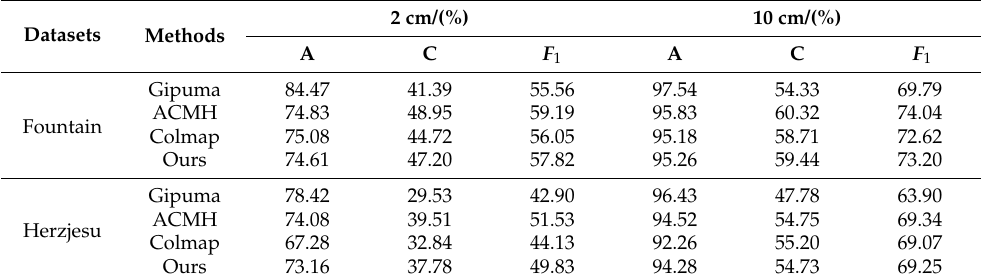
Table 3. The precision comparison of point clouds with different methods in the Strecha dataset. The accuracy (A), completeness (C), and F 1 score (in %) are evaluated with 2 cm and 10 cm thresholds.